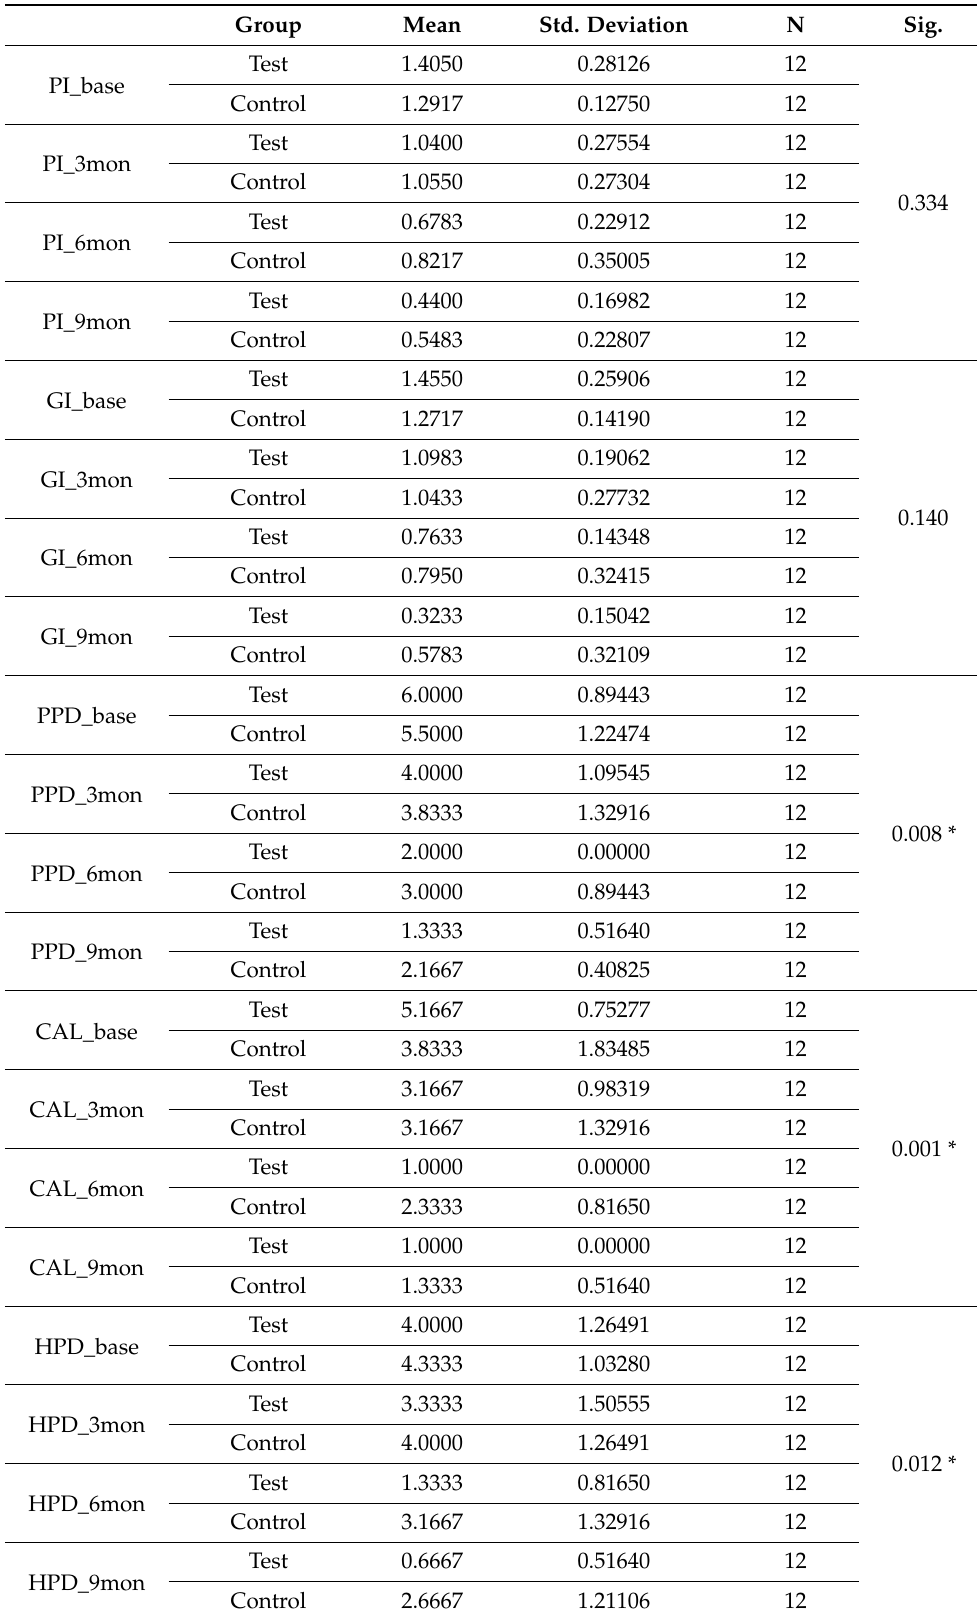
Table 3. Comparison of mean clinical parameters scores of within groups at baseline, 3 months, 6 months and 9